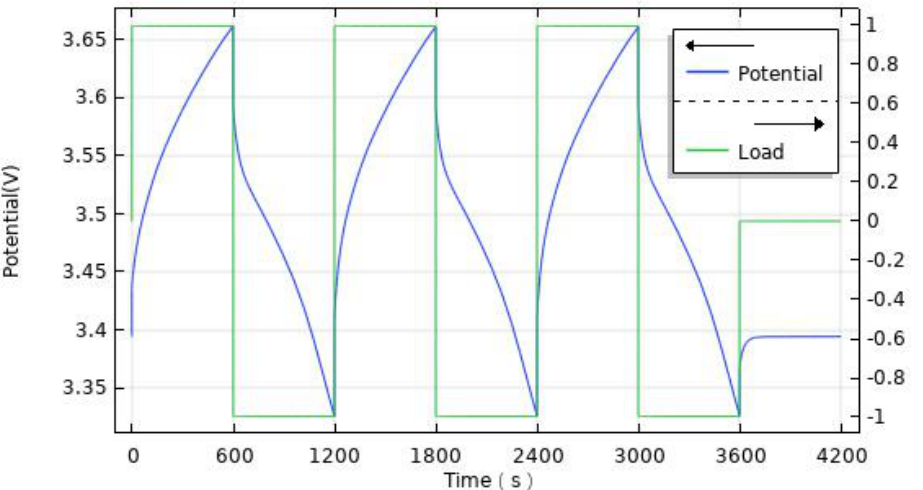
Figure 6. The simulated battery load and potential curve (1 C).